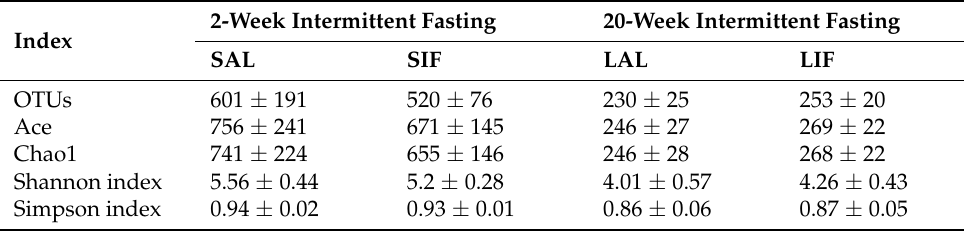
Table 1. Richness and diversity of the faecal microbiota of each